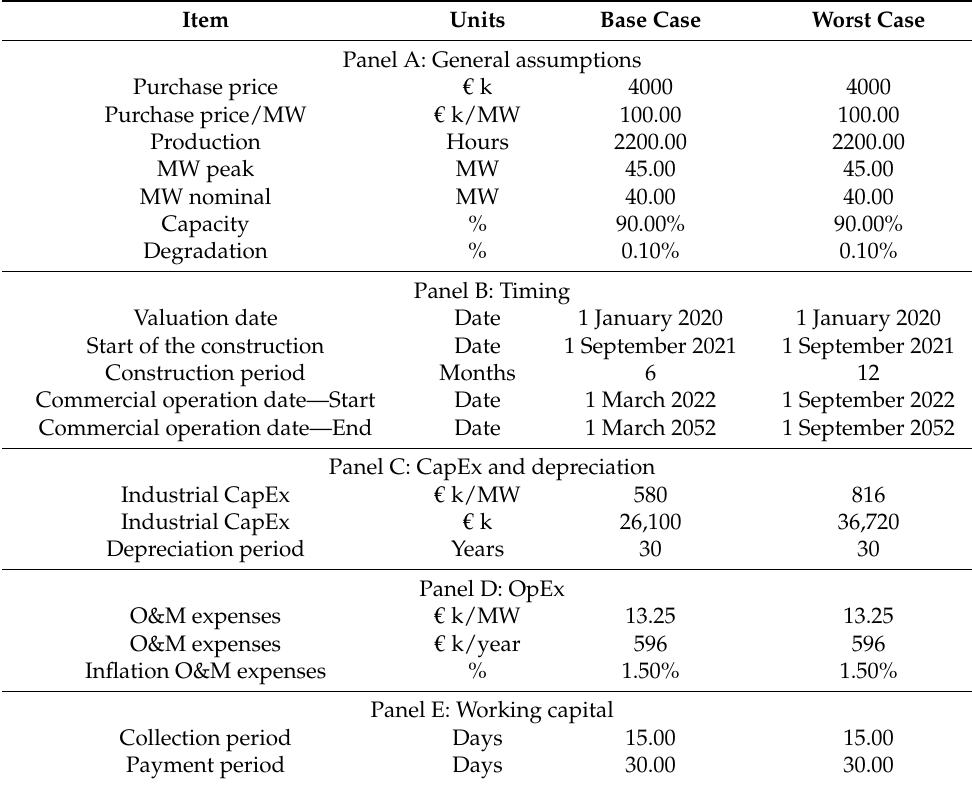
Table 1. Operational